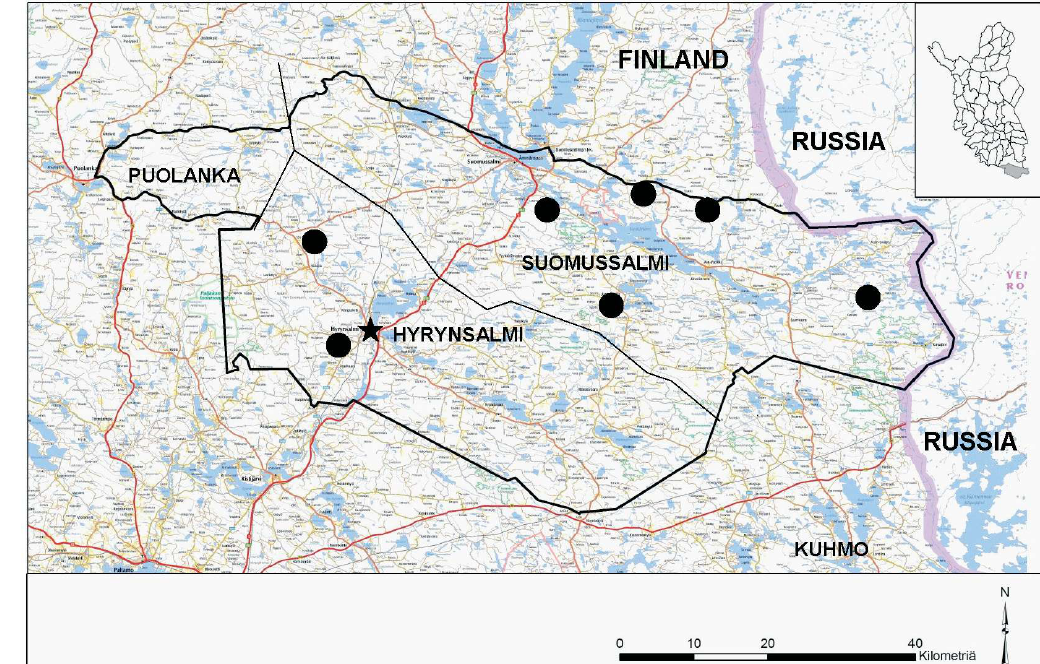
Fig. 1. Study area, the reindeer-herding cooperative of Halla, where reindeer calves and also adult females were fitted with radio-collars in different corrals (•) in 2006-08. The village of Hyrynsalmi is shown (*). smaller reindeer females (Bardsen et al.,